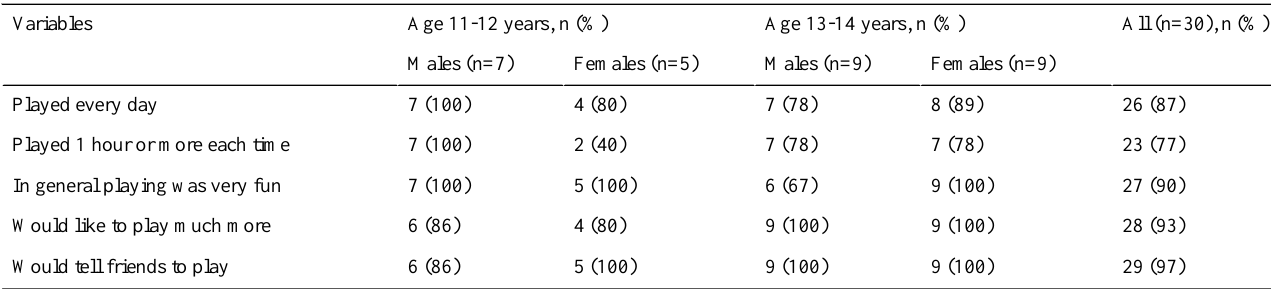
Table 2. Frequency and percentage of respondents responding most positively to questions on appeal by